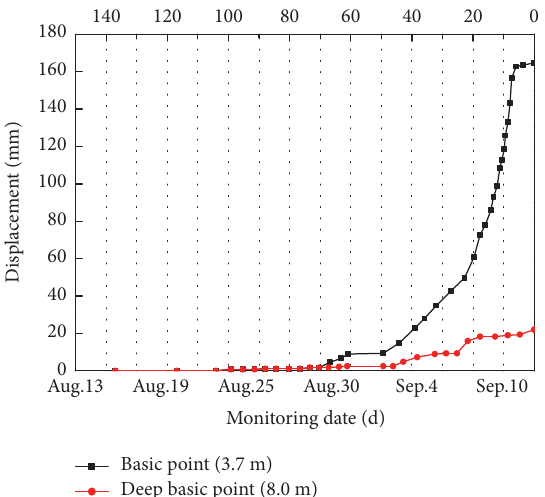
Figure 13: Hydraulic fracturing section: displacement variation of surrounding rock monitored by 2# station.